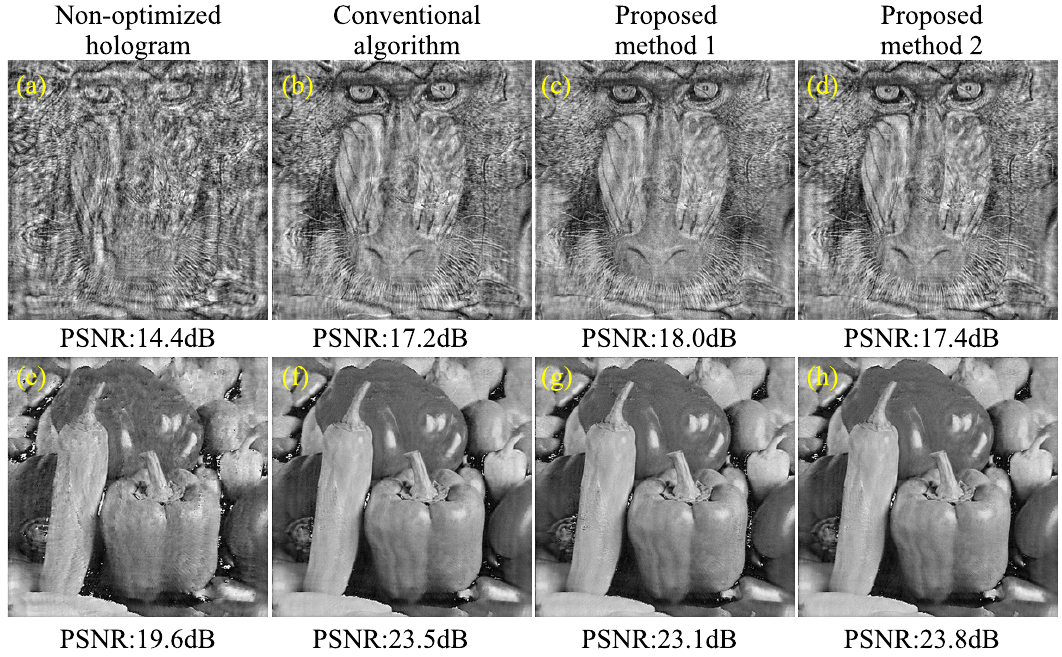
Figure 4. Reconstructed amplitude images ( upper row ) and phase images ( bottom row ) obtained from non-optimized hologram and optimized holograms, respectively.